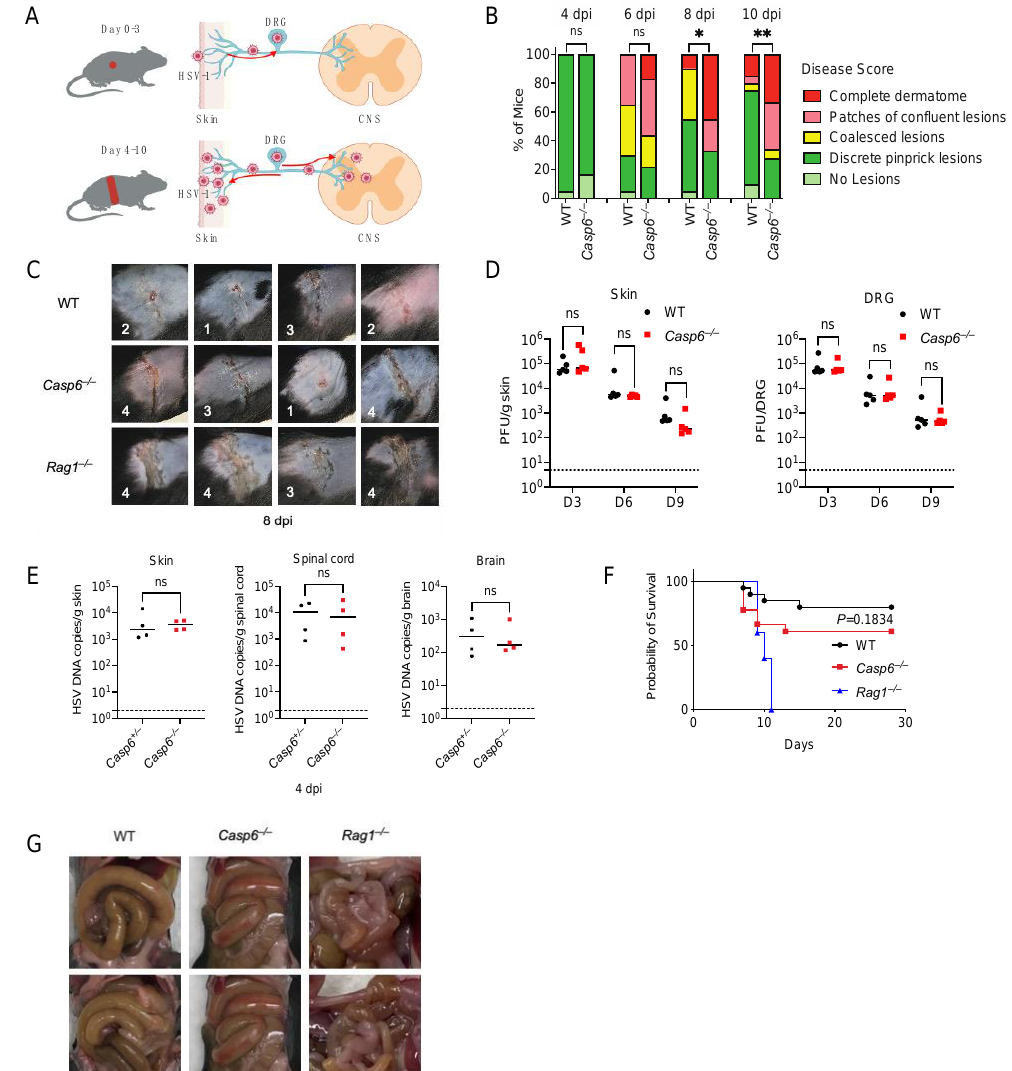
Figure 1. Caspase-6 plays a modest role in defending against HSV-1 skin infection. Mice were infected on the right flank with 10 5 PFU HSV-1 strain NS. ( A ) Model for HSV-1 mouse flank infection. ( B ) Disease score at day 4, 6, 8, and 10 post-infection (dpi) between WT ( n = 20) and Casp6 –/– ( n = 18) mice. ( C ) Representative skin lesion images at 8 dpi of WT, Casp6 –/– , and Rag1 –/– mice. Disease scores are annotated on each image. ( D ) HSV-1 titers in skin and DRG of WT ( n = 5, 5, 5 for 3, 6, 9 dpi) and Casp6 –/– ( n = 5, 5, 5 for 3, 6, 9 dpi) mice at 3, 6, and 9 dpi were determined by plaque assay on Vero cells. ( E ) HSV-1 DNA copies were determined at 4 dpi in the skin, spinal cord, and brain of littermate control of Casp6 +/– ( n = 4) and Casp6 –/– ( n = 4) mice by qPCR. ( F ) Survival was monitored between WT ( n = 20), Casp6 –/– ( n = 18) and Rag1 –/– ( n = 5) mice. ( G ) Representative intestine images of moribund WT, Casp6 –/– , and Rag1 –/– mice. Data are representative of three ( B , G ) or two experiments ( F ). Dashed lines indicate detection limit. ns: not significant; * p < 0.05; ** p <